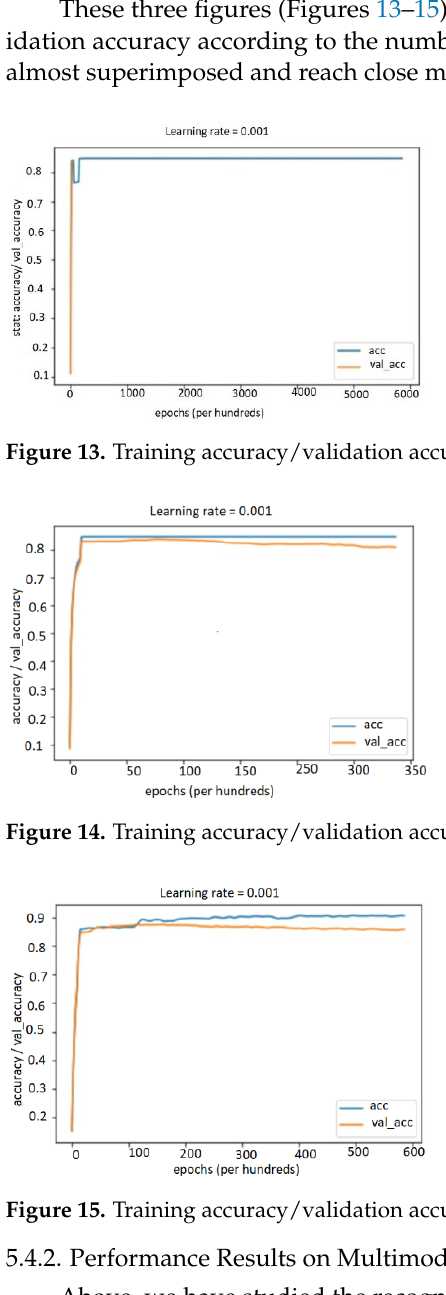
Figure 12. Training accuracy versus epochs for bimodal (text + audio) modality.